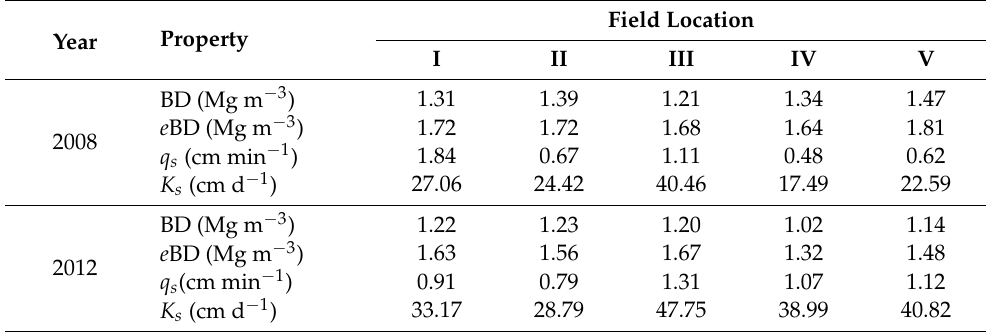
Table 3. Soil physical properties in 2008 and 2012 field campaigns under organic farming.